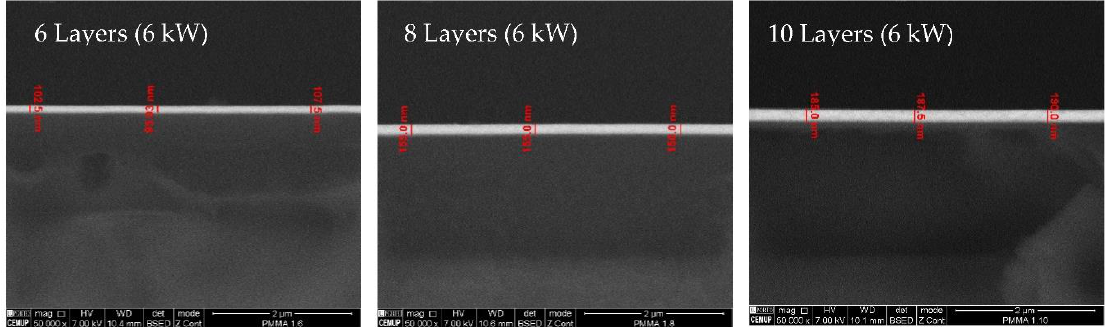
Figure 5. Cross-section view of the films obtained using 6 kW power. In view we can see the samples with 6, 8, and 10 layers of thickness.